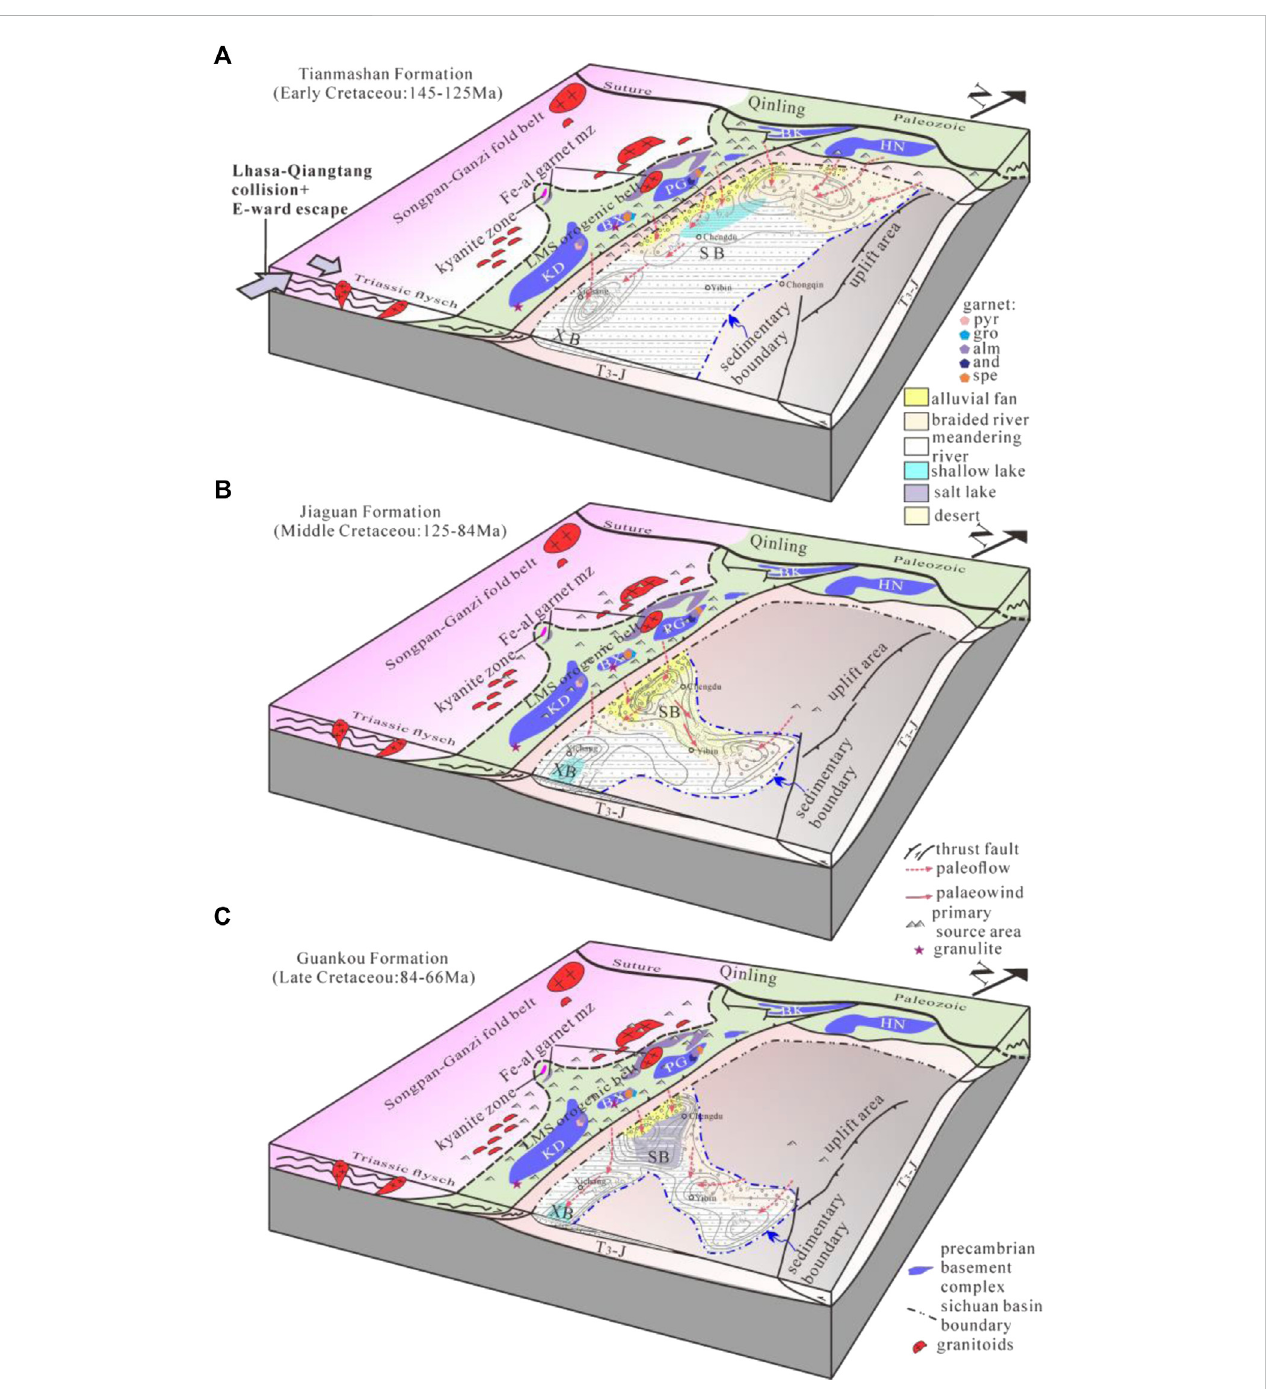
FIGURE 15 Schematicblockdiagrams illustrating exhumationhistoryoftheEastmarginofTibeteanPlateau,andtectonosedimentaryevolutionofitsforelandbasin. (A) EarlyCretaceous, (B) MiddleCretaceous,and (C) LateCretaceous.IsopachmapsafterGuoetal.(1996).HN.Hannan;BK.Bikou;KD.Kangdian;BX.Baoxing. PG. Pengguan; mz. metamorphic zone; SB. Sichuan Basin; XB. Xichang